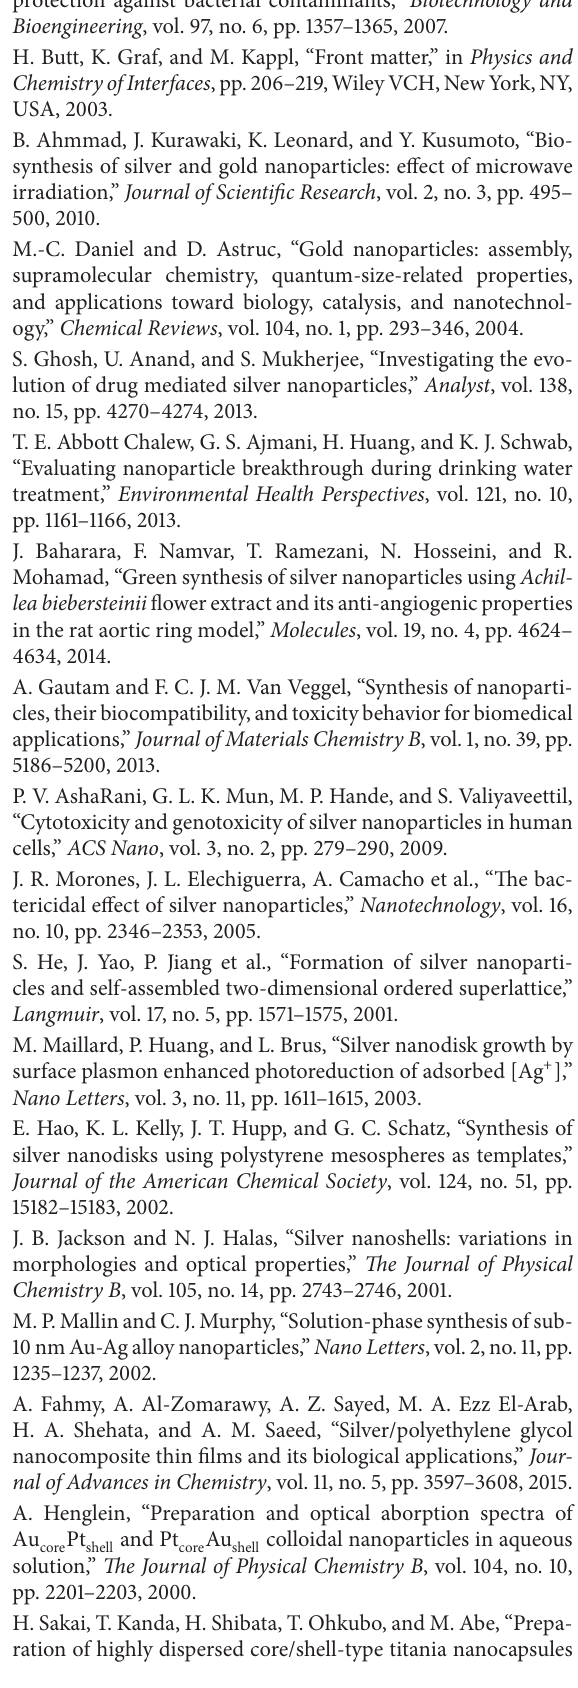
Table 4: pH results during all steps in the synthetic